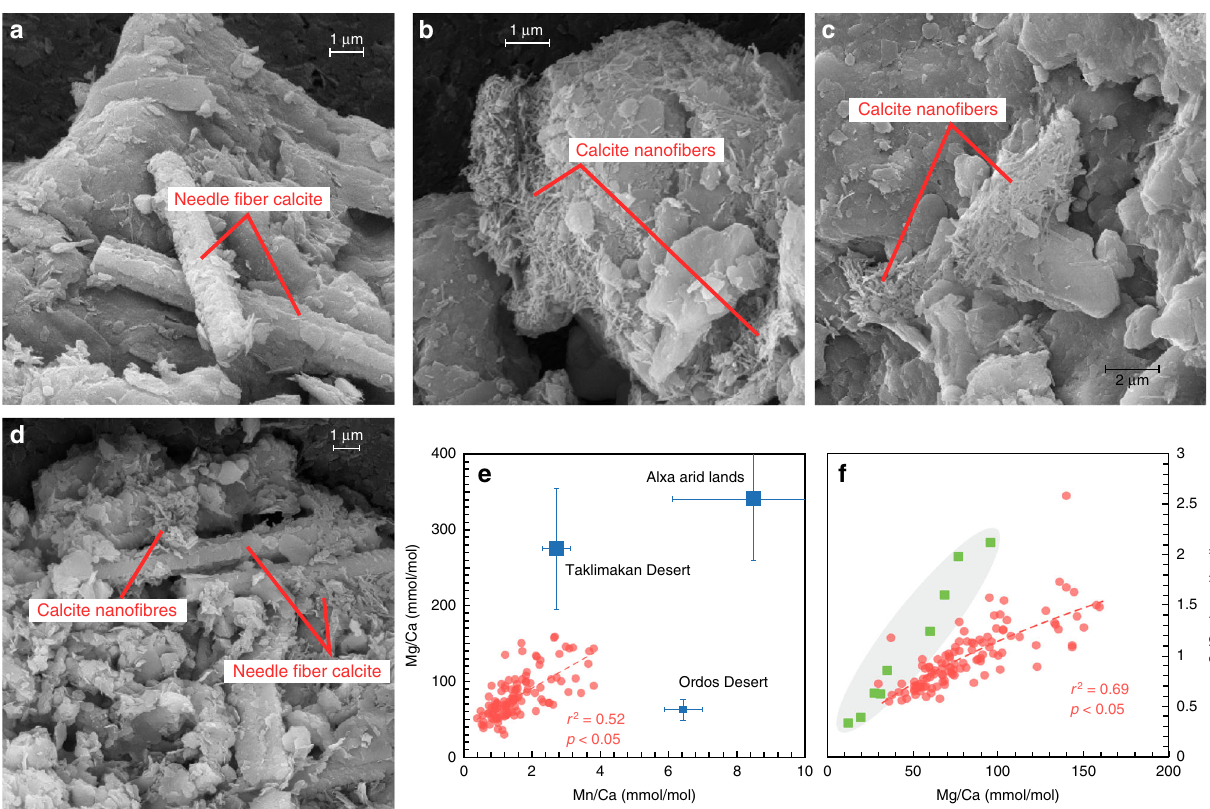
Fig. 1 Micromorphology and geochemistry of pedogenic carbonates. a Needle fi ber calcites (NFC) in the inner channel of hypocoatings. b and c Randomly organized mesh of calcite nano fi bers. d Sparsely distributed nano fi bres lying on the surfaces of NFC. e Cross plots of Mn/Ca and Mg/Ca ratios of fi nely disseminated carbonate (FDC) samples in this study (red dots), compared with detrital carbonates from potential source regions (blue squares) 32 . Error bars represent standard deviations from multiple samples ( n > 3). f Cross plots of Sr/Ca and Mg/Ca ratios of FDC samples in this study, compared with those of microcodium (green squares) in Holocene soils on the Chinese Loess Plateau